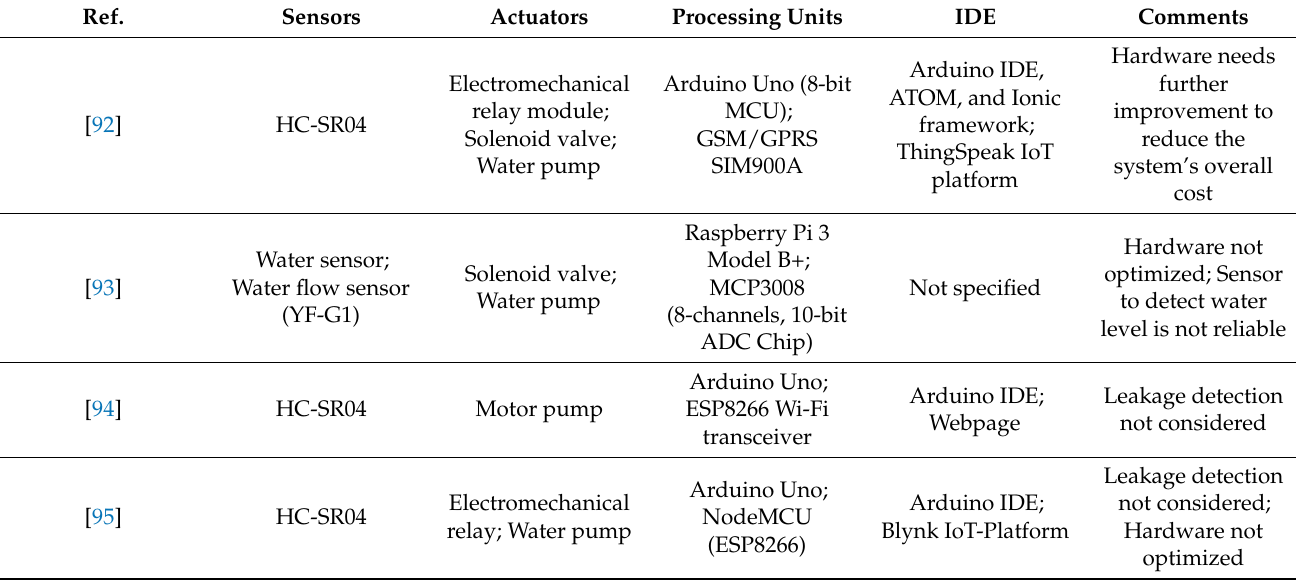
Table 3. Comparison of contemporary